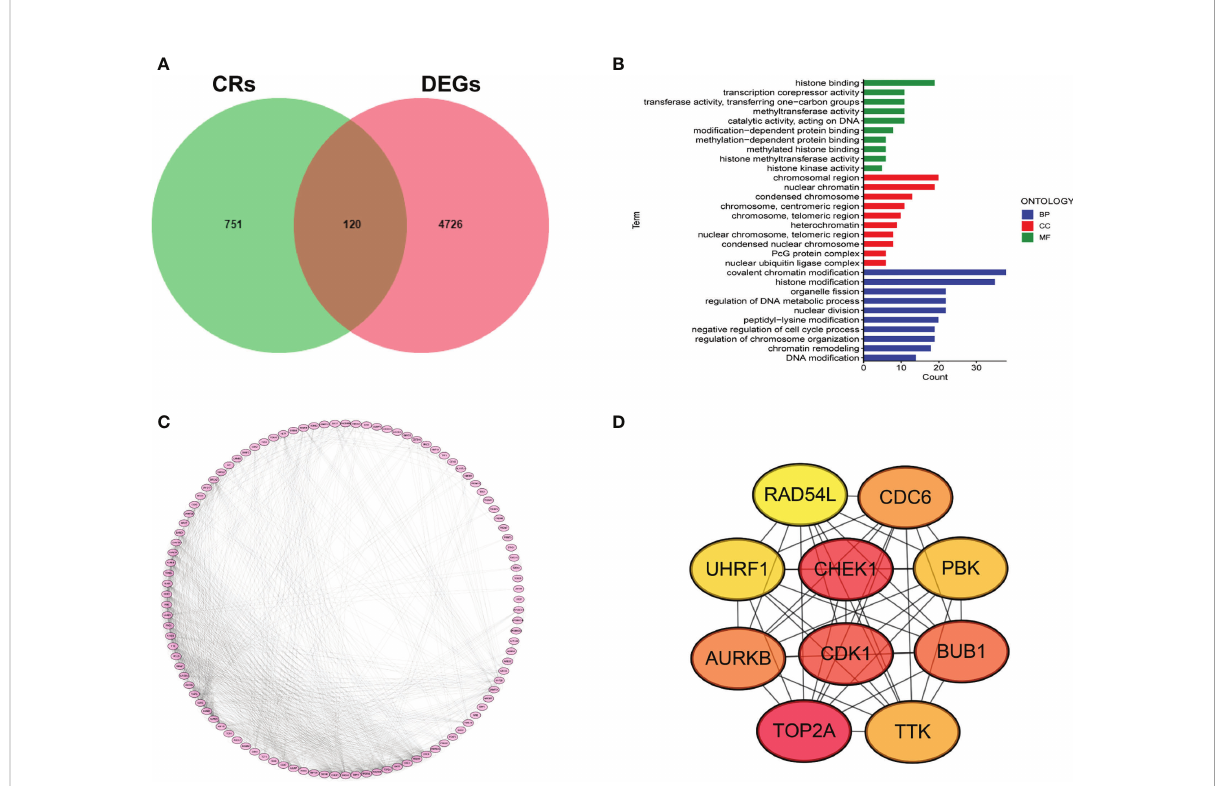
FIGURE 1 Determination of DECRs in LUAD. (A) Venn diagram of DECRs. (B) KEGG analysis of DECRs. (C) PPI network for 120 DECRs. (D) The top ten hub genes of DECRs-based PPI